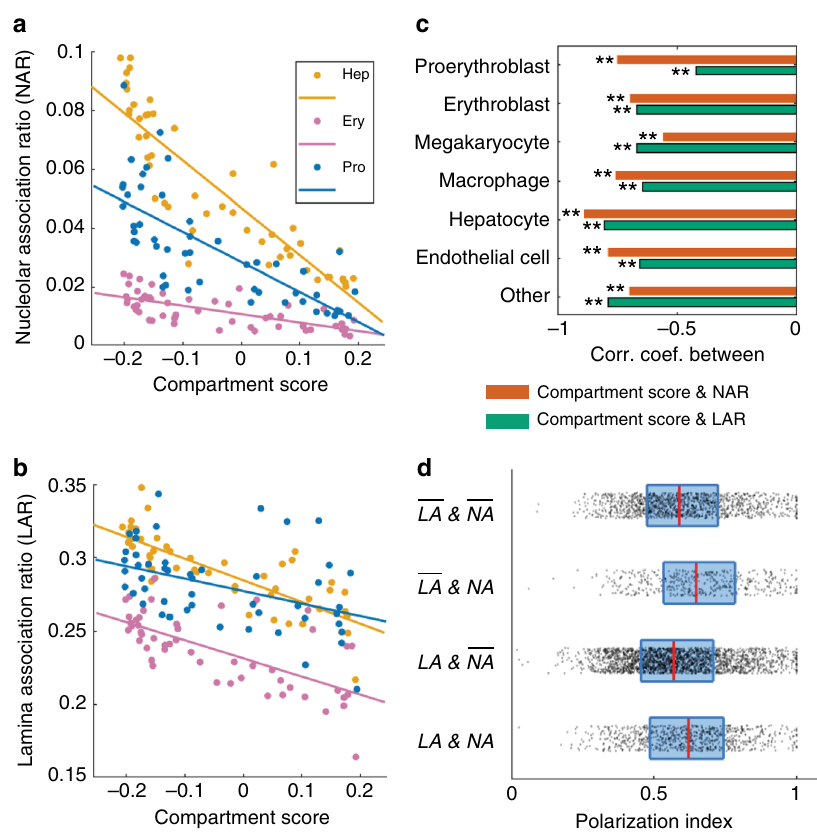
Fig. 4 Correlations between multiple nucleome architectural features. a Nucleolar association ratios of TADs versus their compartment scores in hepatocytes (Hep), erythroblasts (Ery) and proerythroblasts (Pro). b Lamina association ratios of TADs versus their compartment scores in the three cell types above. c Correlation coef fi cients between compartment scores and lamina or nucleolar association ratios in all identi fi ed cell types. ** p = (top to bottom) 4e-10, 2e-3, 2e-8, 1e-7, 2e-5, 1e-7, 2e-10, 4e-7, 7e-18, 2e-12, 1e-11, 2e-7, 1e-8, 1e-11. The p values were calculated for Pearson ’ s correlation using a two-sided Student ’ s t distribution. No adjustment was made for multiple comparisons. d Polarization indices for chromosomes with or without nucleolar or lamina association (with compartment B) in proerythroblasts. LA and NA : with neither lamina nor nucleolar association ( n = 1277 chromosomes, median = 0.59, 25% quantile = 0.48, 75% quantile = 0.72, minimum = 0.09, maximum = 1). LA and NA : without lamina association but with nucleolar association ( n = 465 chromosomes, median = 0.65, 25% quantile = 0.53, 75% quantile = 0.78, minimum = 0.06, maximum = 1). LA and NA : with lamina association but without nucleolar association ( n = 2267 chromosomes, median = 0.57, 25% quantile = 0.45, 75% quantile = 0.71, minimum = 0.02, maximum = 1). LA and NA : with both lamina and nucleolar associations ( n = 821 chromosomes, median = 0.62, 25% quantile = 0.49, 75% quantile = 0.74, minimum = 0.03, maximum = 1). Dots, lines and boxes are de fi ned as in Fig. 3e. Source data are provided as a Source data fi